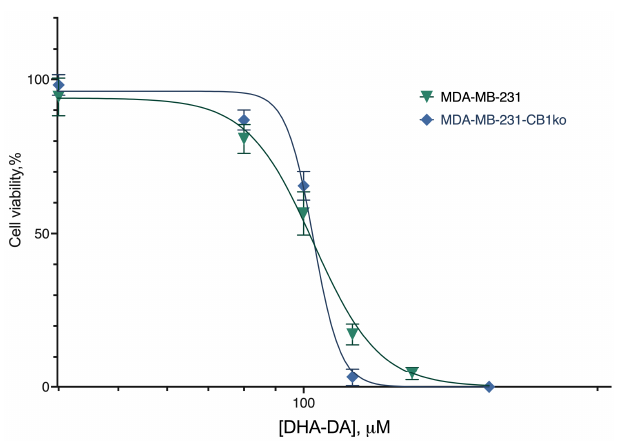
Figure 1. The effect of CB1 knockout on DHA ‐ DA cytotoxicity. Incubation 24 h, MTT test, mean ± standard deviation ( n = 7 experiments).